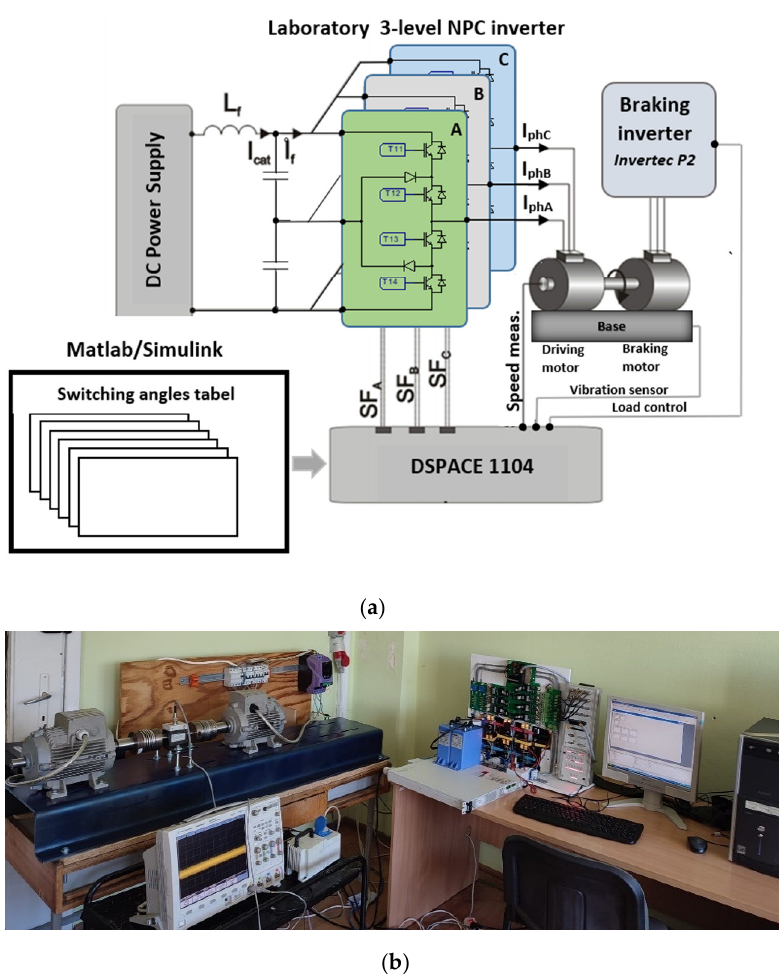
Figure 2. The laboratory stand setup: ( a ) simplified scheme; ( b ) laboratory stand.